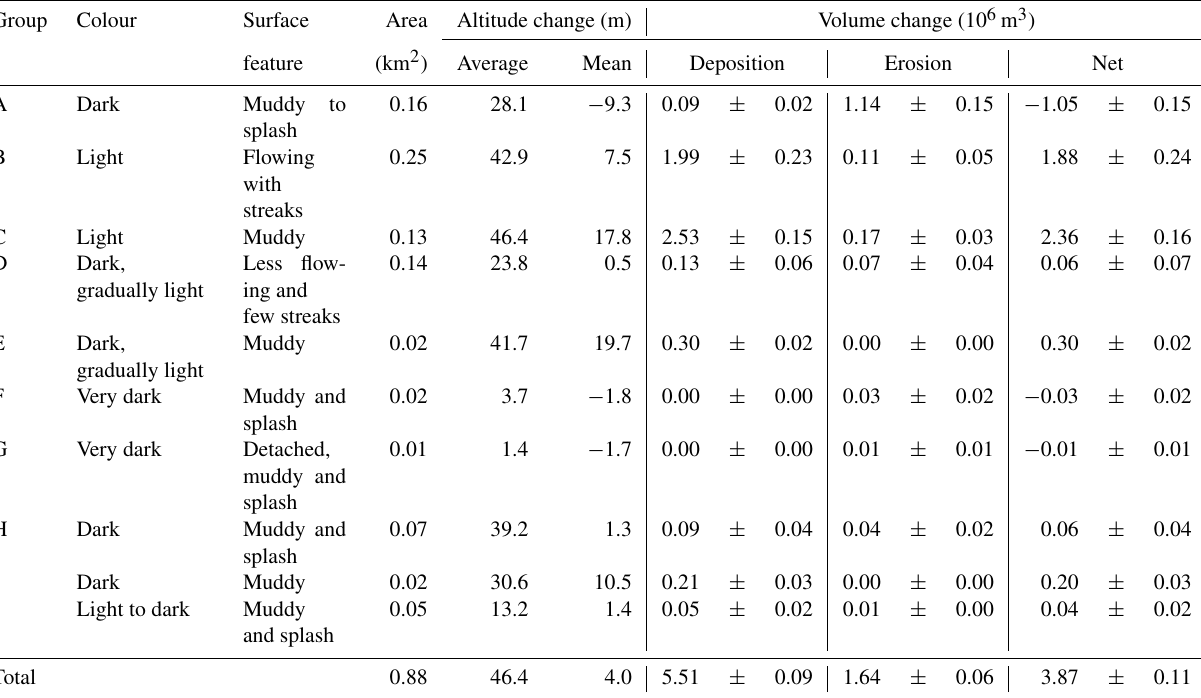
Table 1. Identifiable surface colour and physical features, area, thickness, and volume changes for the 10 classified deposition groups. Group Colour Surface